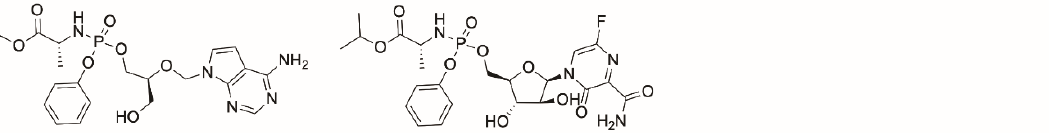
Figure 10. Structures of reported non-nucleoside inhibitors of the Caliciviridae RdRp.